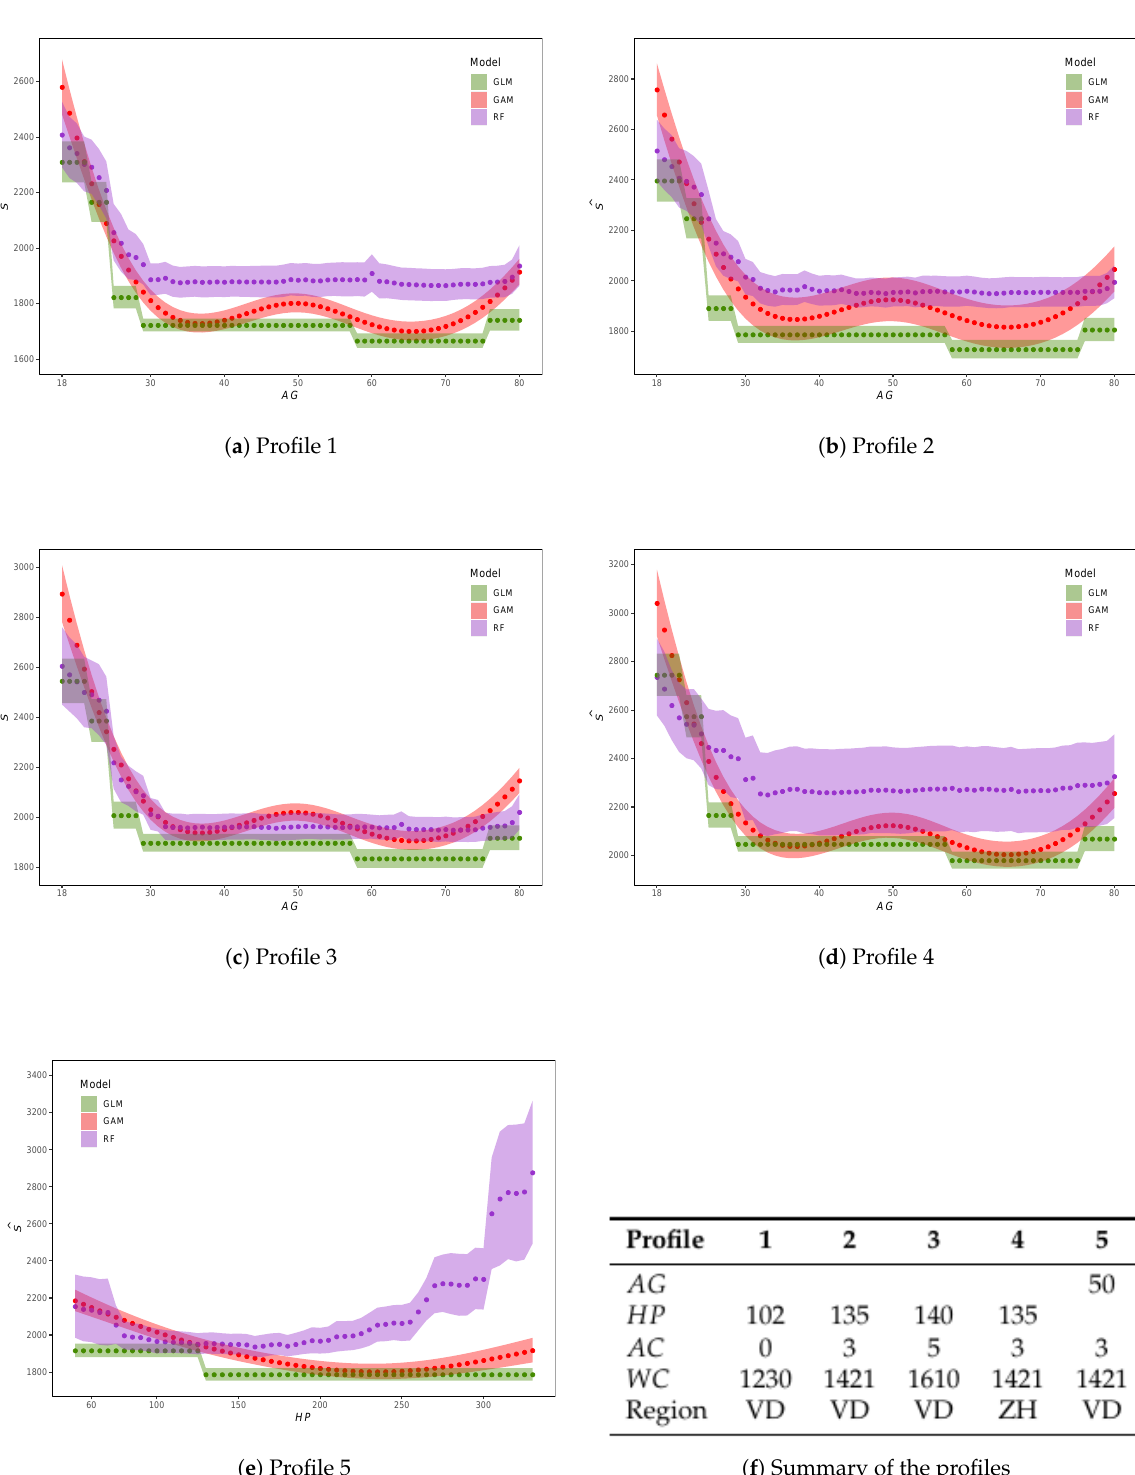
Figure 12. Comparison of the predicted claim severity ˆ S with 95%-confidence intervals along different ages (in graphs a to d for profiles 1 to 4) and horsepower values (in graph e for profile 5) across the GAM, GLM, and RF